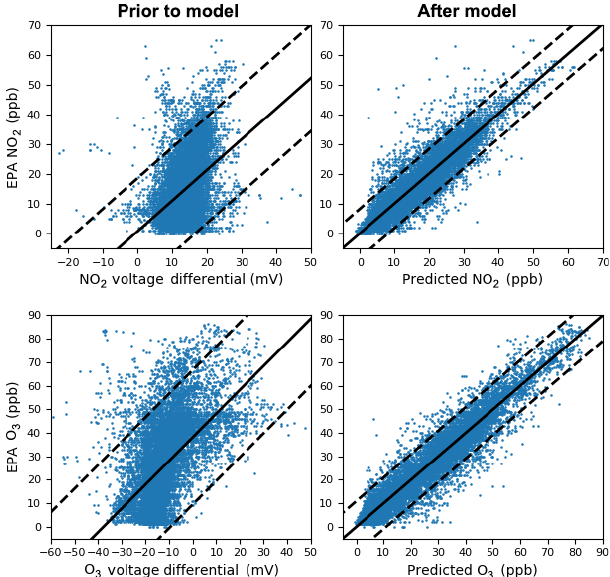
Figure 9. A single board comparison (Board 12) of the relationship between the raw sensor values and target pollutant concentrations (left) and the predicted and target pollutant concentrations after the model was run (right) for the Level 1 split-NN (9) condition. The solid black line is a linear trend line and the dashed lines represent the 95th